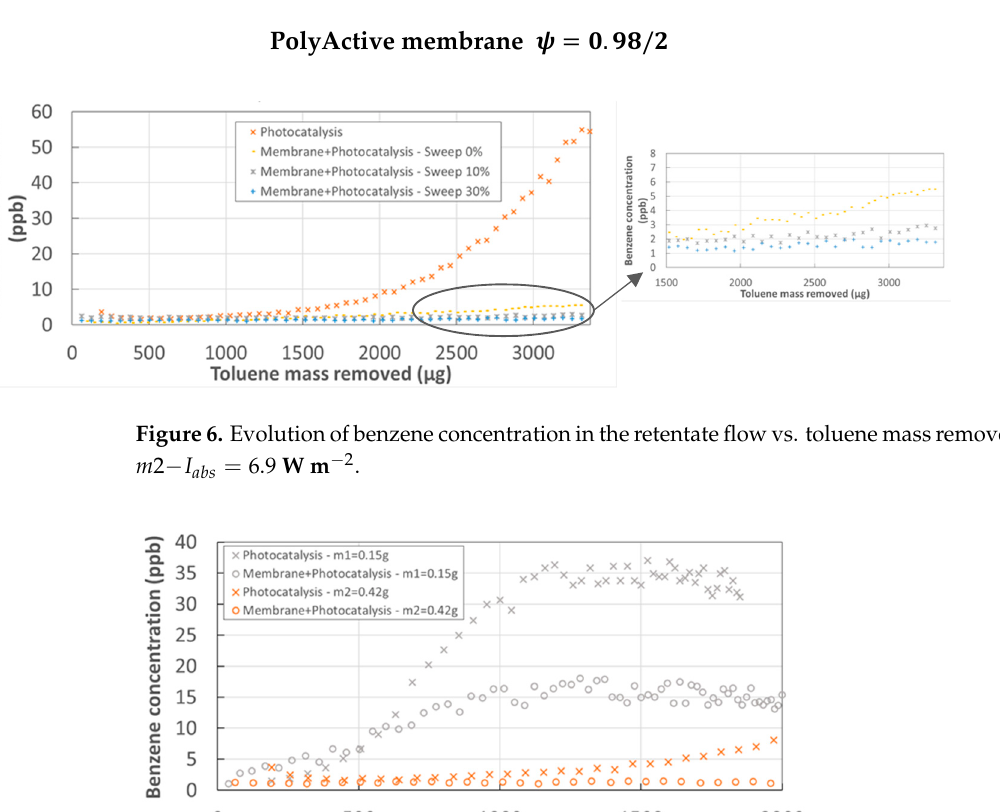
Figure 8. Toluene recovery ratio vs. toluene mass removed for catalysts m 1 and m 2—PDMS mem ‐ brane Sweep gas = 0% (cid:3398) 𝐼 (cid:3028)(cid:3029)(cid:3046) (cid:3404) 6.9 W m (cid:2879)(cid:2870) (cid:3398) 𝜓 (cid:3404) 0.98/2 . With regard to formaldehyde, the concentration in the outlet effluents was monitored for the different configurations as a function of the mass of toluene removed. Figure 9 shows the results for PCO alone of toluene and for the hybrid configuration. All the tests were conducted with an absorbed light intensity of 6.9W m − 2 by the m 2 catalyst and with a 30% sweep gas. PCO alone led to the formation of formaldehyde from 1500 μ g of de ‐ composed toluene and the concentration reached about 25 ppb at the end of the experi ‐ ment. In the case of the membrane ‐ PCO association, the appearance of formaldehyde was much less considerable than in the previous case and the presence of formaldehyde in the retentate stream was around 10 ppb and 5 ppb for a pressure ratio ψ of 0.98/1.3 and 0.98/2 respectively. Although this is less significant than for benzene, the hybrid configuration contributed to limiting the presence of formaldehyde in an effluent that could be reused. Moreover, although parameter ψ has a strong influence on the trapping effect of the sys ‐ tem, the nature of the membrane material, its surface, its thickness, and its implementation were decisive parameters for accentuating and increasing the capacity of the hybrid de ‐ vice to limit the presence of TPs in the retentate side.